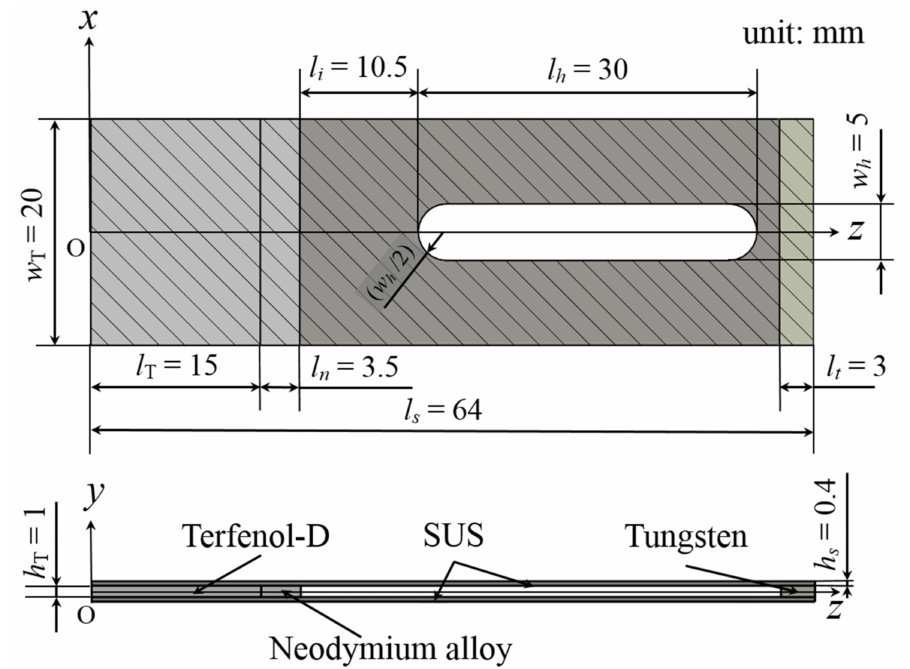
Figure 1. Illustration of the used energy harvesting